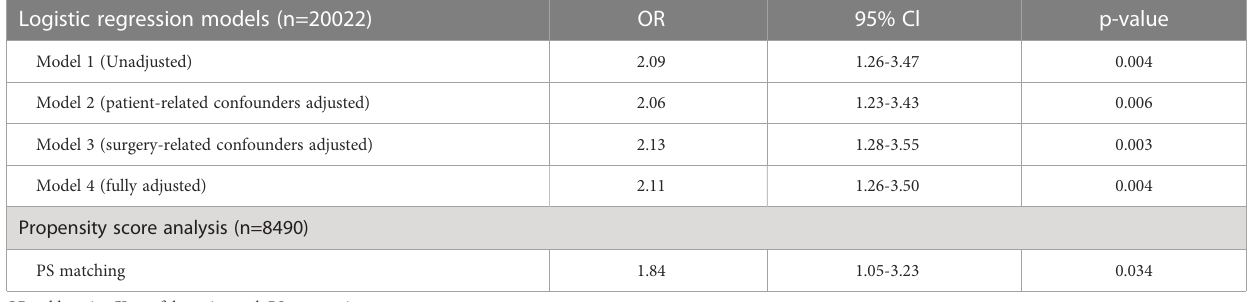
TABLE 2 Logistic regression and propensity score analysis of the association between penicillin allergy and orthopedics surgical site infection. Logistic regression models